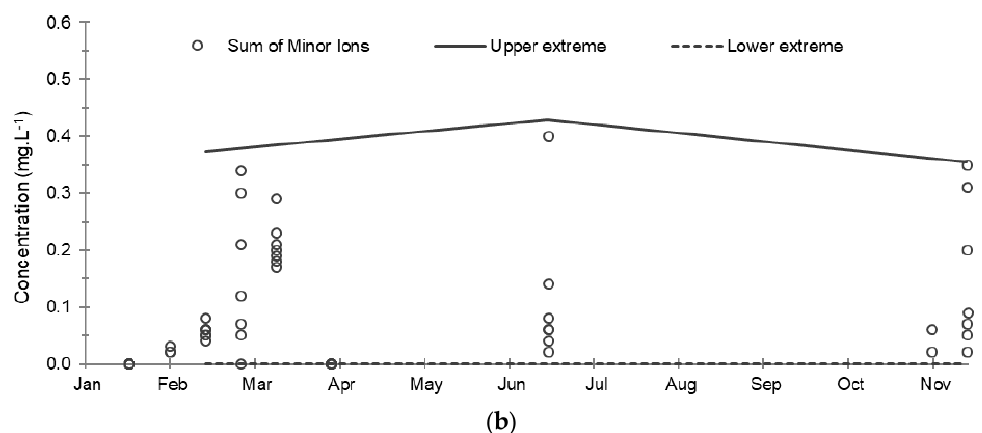
Figure 6. Evolution of the cumulative concentrations of major and minor ions and their extreme limits during the establishment of the baseline in 2019: ( a ) Sum of major ions; ( b ) Sum of minor ions. The solid and dashed lines correspond respectively to the upper and lower extreme limits calculated according to the Tukey’s formula: Q1 − 1.5 (Q3 − Q1) and Q3 + 1.5 (Q3 − Q1) where Q1 and Q3 are the 1st and 3rd quartiles.